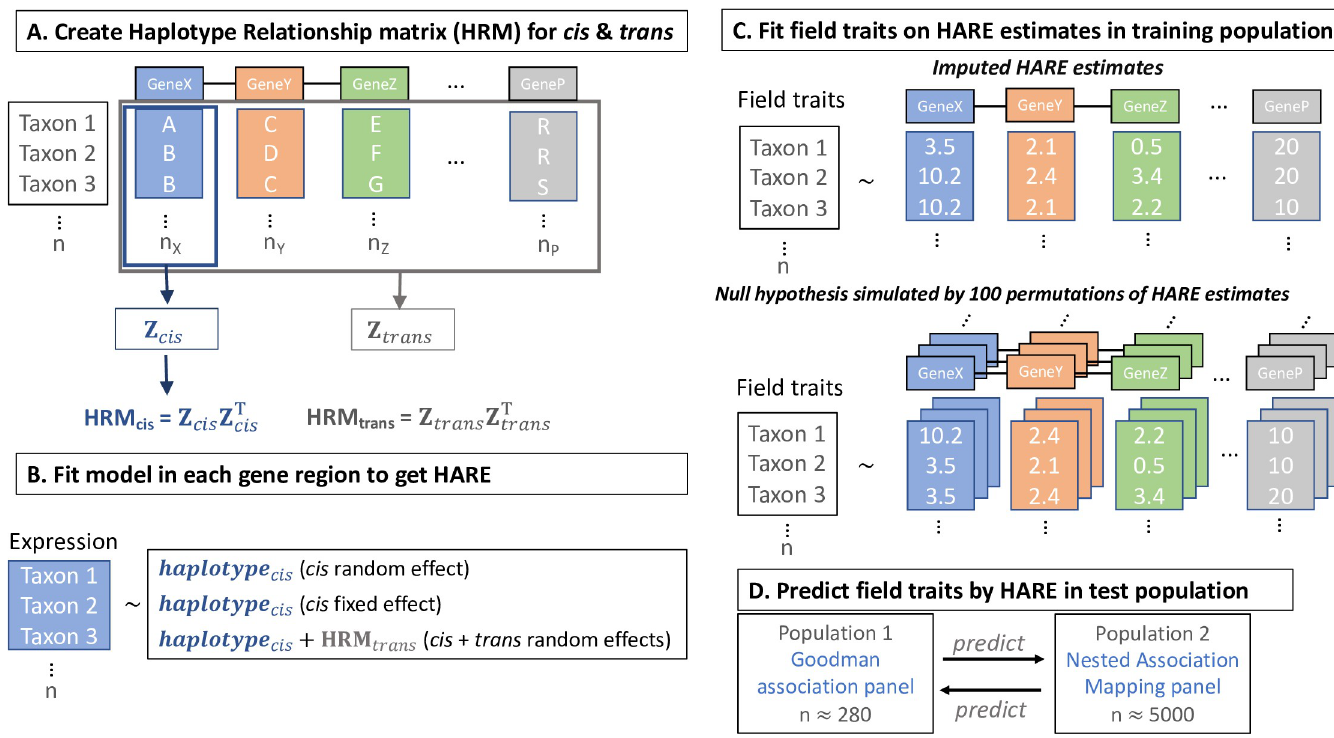
Fig 1. Experimental methods on calculating haplotype associated RNA expression (HARE) and using HARE to predict complex traits. A. The haplotypes of 26 NAM founders and one additional stiff stalk inbred line were identified in each gene region of the Goodman Association panel by mapping GBS reads (presented in detail in Valdes Franco et al. [27]) to the indexed pangenome of 27 lines. Haplotype relationship matrices (HRM ) were created in each gene region and all genic cis HRM cis were combined to get HRM trans to control for trans effects, B. Using gene expression from 7 tissues [26], fixed or random effects models were fitted in each gene region with or without controlling for trans effects for each gene, C. Models were trained using field phenotypes in the Goodman panel or the NAM panel using HARE estimates or 100 randomly permuted HARE values while preserving haplotype structure, and D. Trained models were used to predict complex traits across populations.